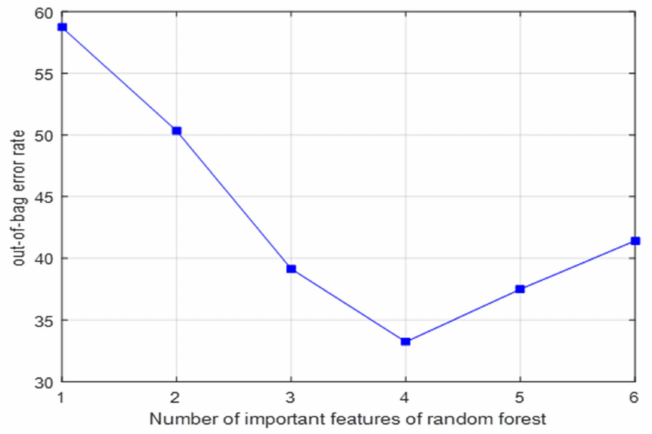
Figure 7. Relationship between OOB error rate and number of important features.